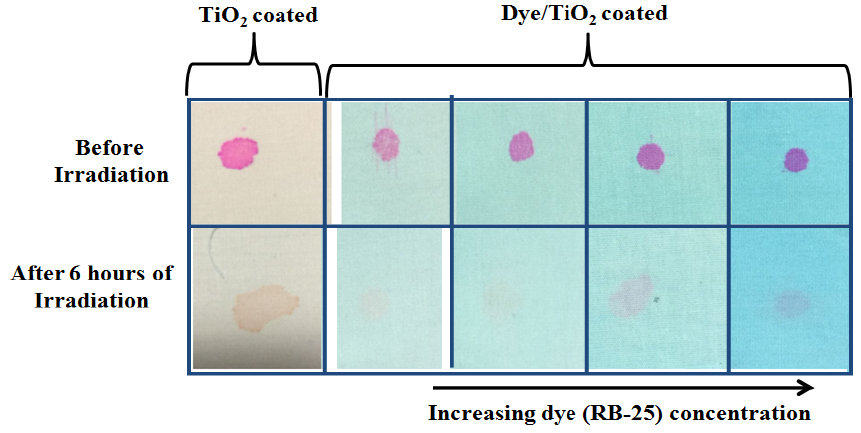
Figure 13. The images of stain degradation on fabrics during the self ‐ cleaning test.